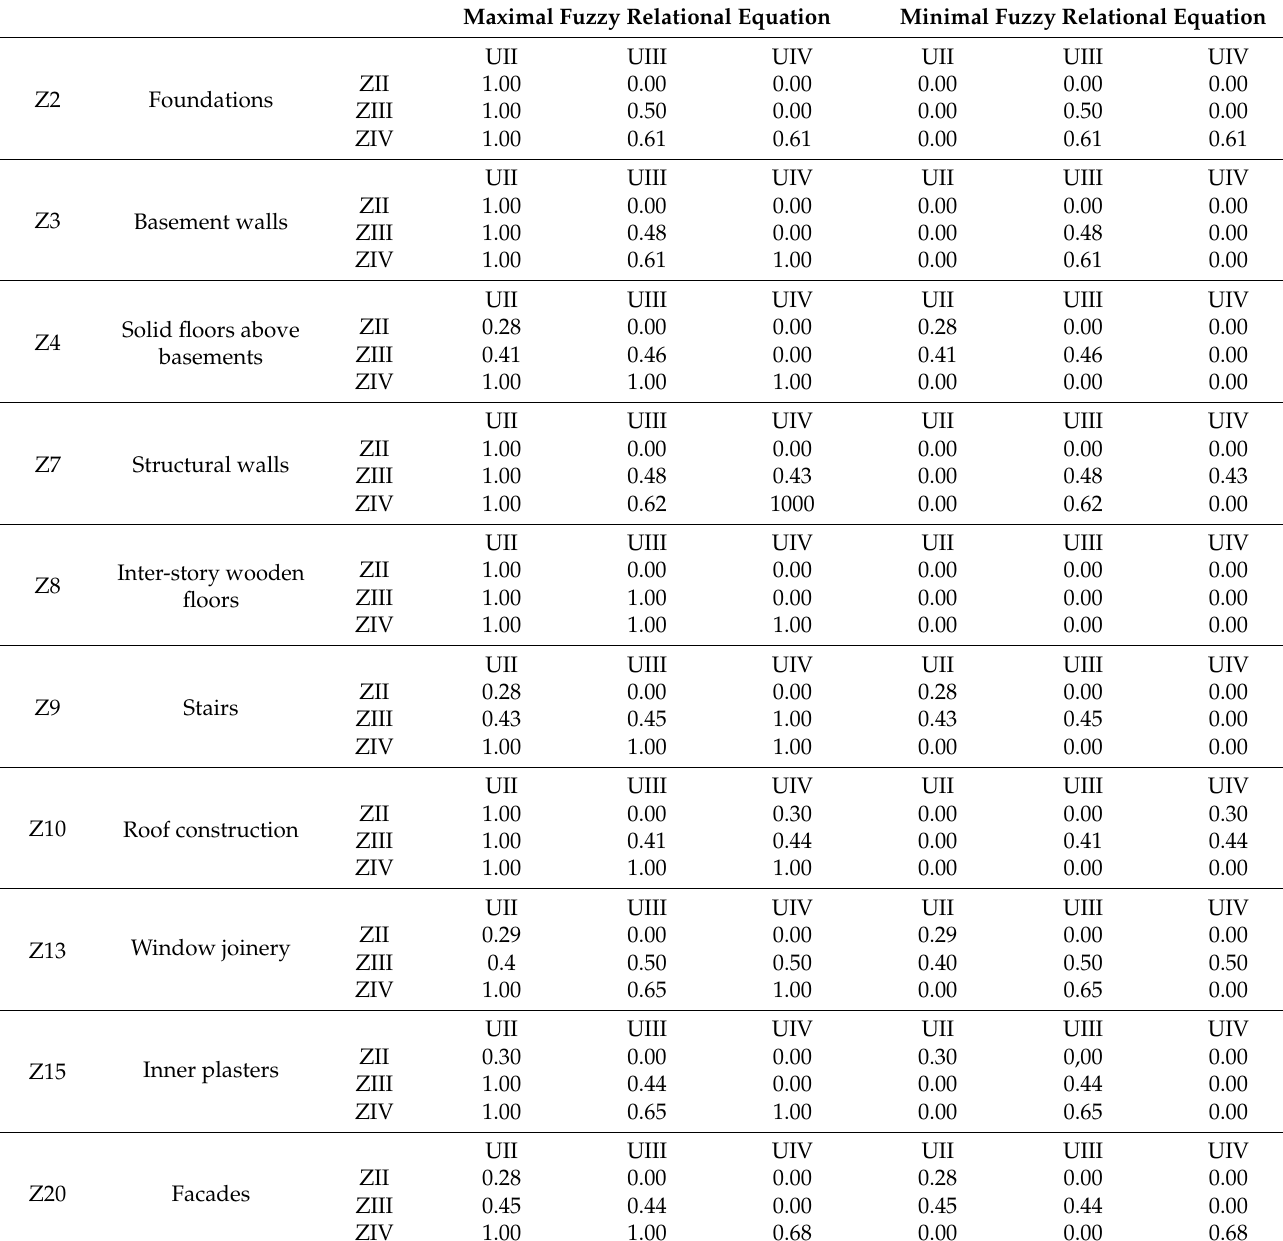
Table 5. Maximal and minimal equations of relational damage to elements in the II, III, and IV maintenance class of a residential